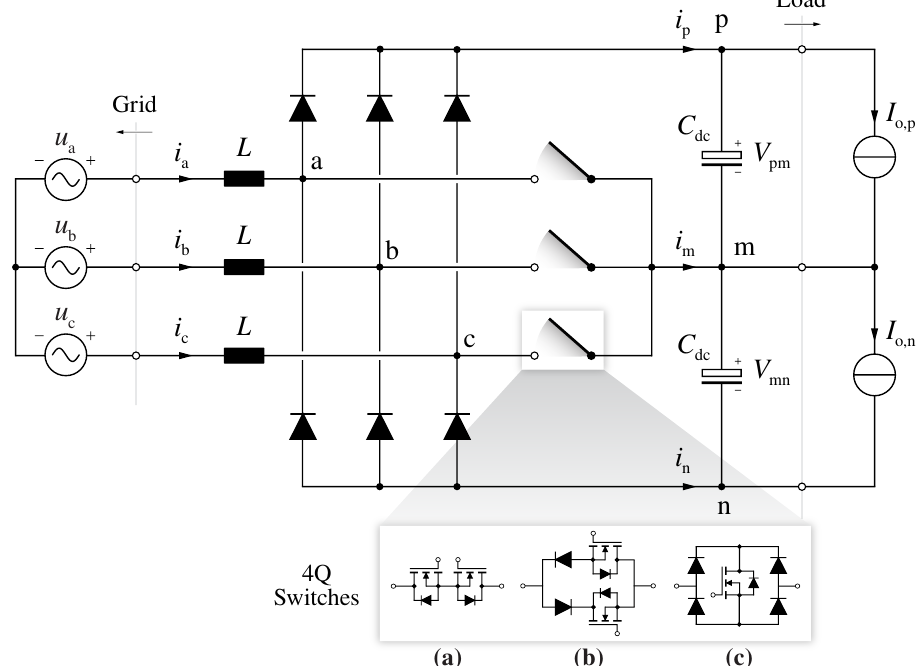
Figure 2. Schematic overview of a three-level rectifier connected to the three-phase grid. The mid- point switches must be bipolar and bidirectional, i.e., 4-quadrant (4Q). A highlight of the possible 4Q switch topologies is provided, namely ( a ) the T-type, ( b ) the NPC-type, and ( c ) the VIENNA-type: switches ( b , c ) can also be integrated inside the input diode bridge (see